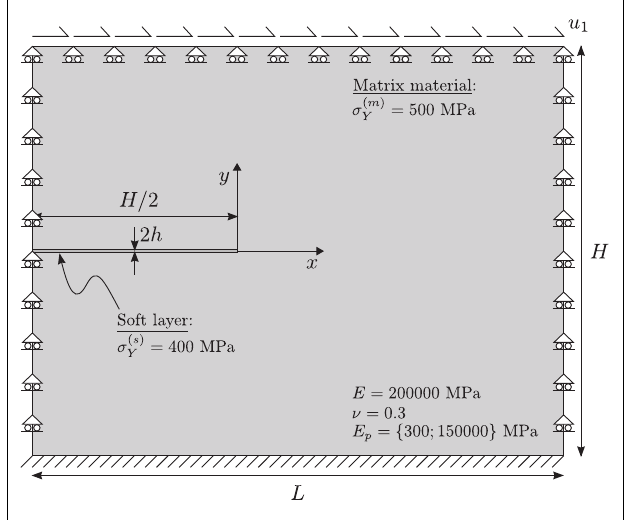
FIGURE 4 | Geometry of the model, material properties, and boundary conditions (which would correspond to a simple shear deformation in the absence of the shear band) .The horizontal displacement u 1 is prescribed at the upper edge of the